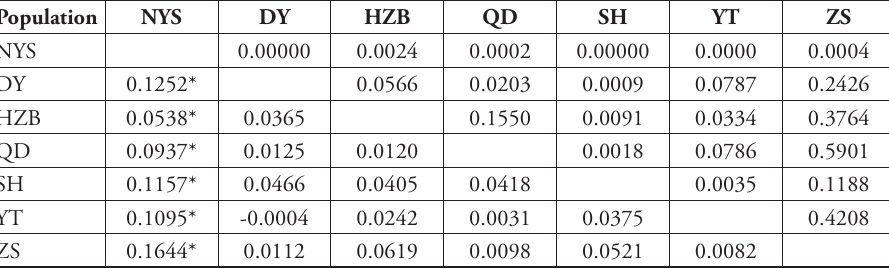
Table 2. Pairwise Fst (below diagonal) and associated P values (above diagonal) among populationsof J.